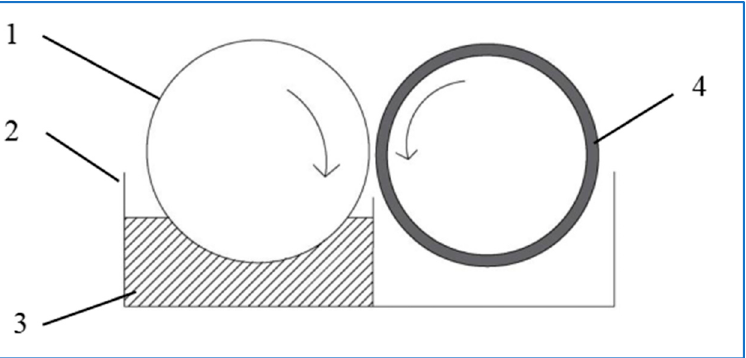
Figure 6. Two rollers model of roll coating simulation test equipment (1—Drawing roller, 2—coating materials box, 3—Coating liquid, 4—Coating roller).